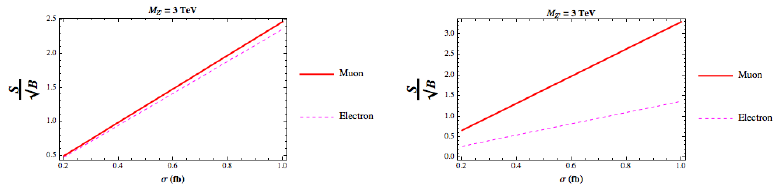
= 3000 at (cid:31) L int 200 GeV and the (cid:31) ± µµ ) = 4 →